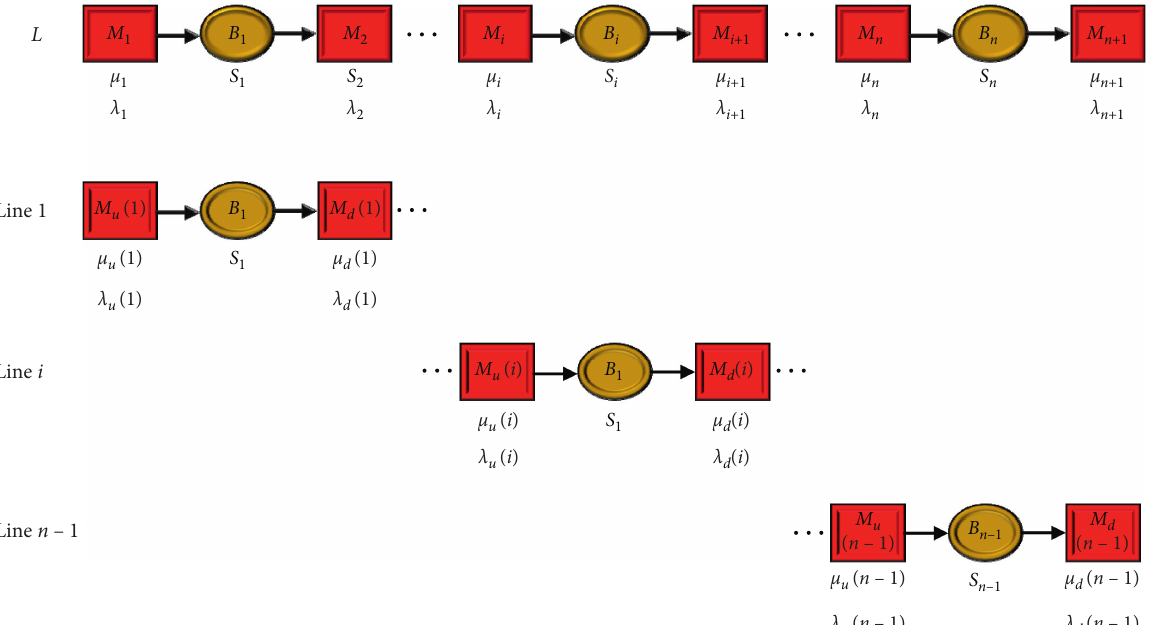
Figure 3: n − 1 virtual series systems after decomposition.